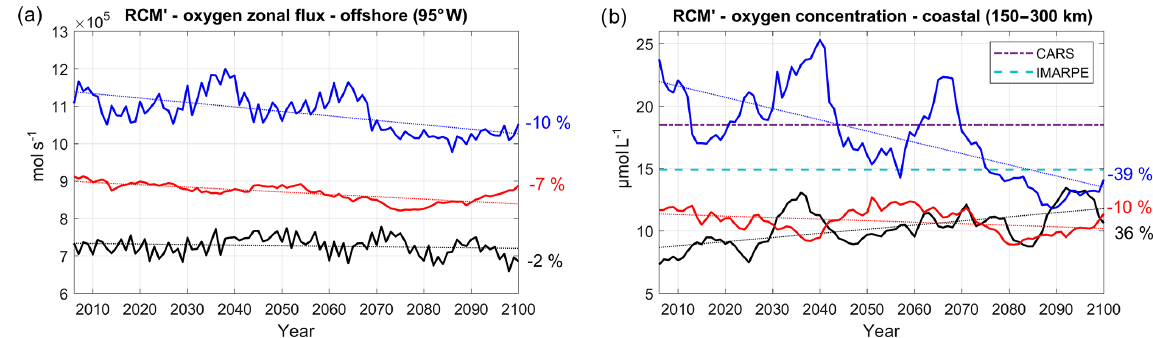
Figure 17. (a) Oxygen flux (molL − 1 , positive eastward) at 95 ◦ W, averaged between 2 ◦ N and 10 ◦ S and between 50 and 200m, and (b) nearshore subsurface oxygen content (averaged between 100 and 200m in a coastal box between 150 and 300km from the coast) for the three RCM’ simulations (CNRM’ in black, GFDL’ in blue, IPSL’ in red). RCM’ simulations are forced by WOA climatological boundary conditions for oxygen. The time series are filtered using a 10-year moving average. CARS (dashed–dotted purple line) and IMARPE (dashed cyan line) climatological values are also